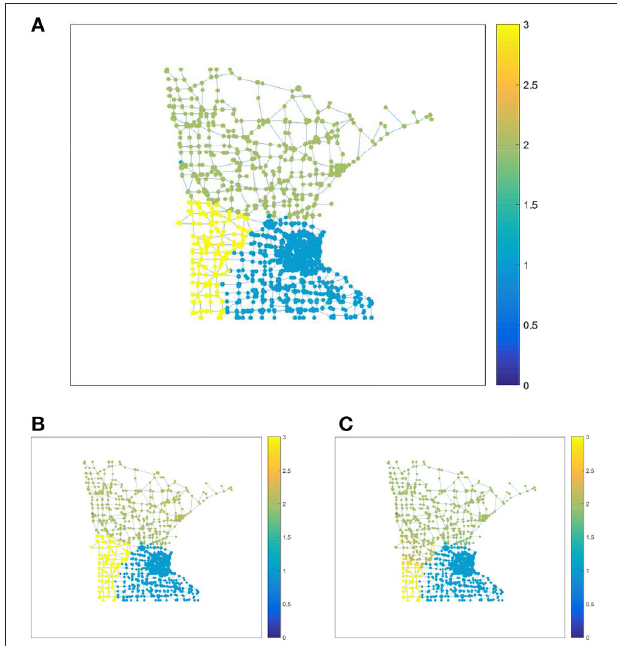
FIGURE 3 | True graph signal (A) and recovered signals for the Minnesota roadmap data set obtained (B) when using sampling set M 1 , (C) or sampling set M 2